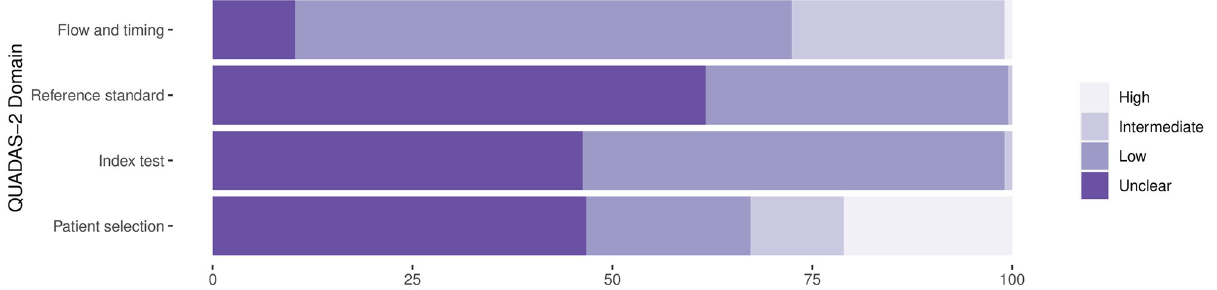
Fig 2. Methodological quality of the clinical accuracy studies: Risk of bias. Proportion of studies with low, intermediate, high, or unclear risk of bias (percent).